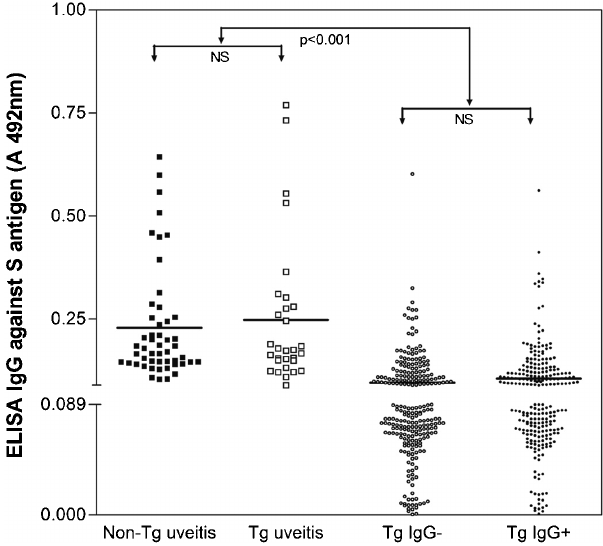
Figure 2 - Antibodies against bovine retina S-antigen in selected patients. Non-Tg uveitis: samples from patients with uveitis other than toxoplasmosis (n=50; see Methods). Tg uveitis: samples from patients with Toxoplasma uveitis (n=30). Tg IgG-: samples from patients who were seronegative for T. gondii (n=250). Tg IgG + : samples from patients who were seropositive for T. gondii . Bars represent mean values. The y-axis was interrupted at cut-off using the mean minus 2 SD of samples from all uveitis patients.